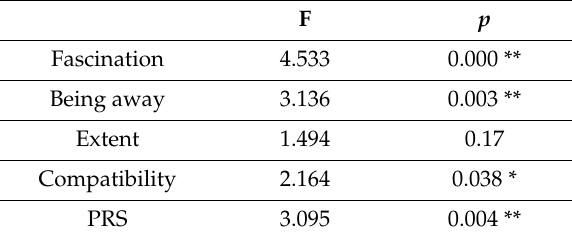
Table A3. ANOVA results.